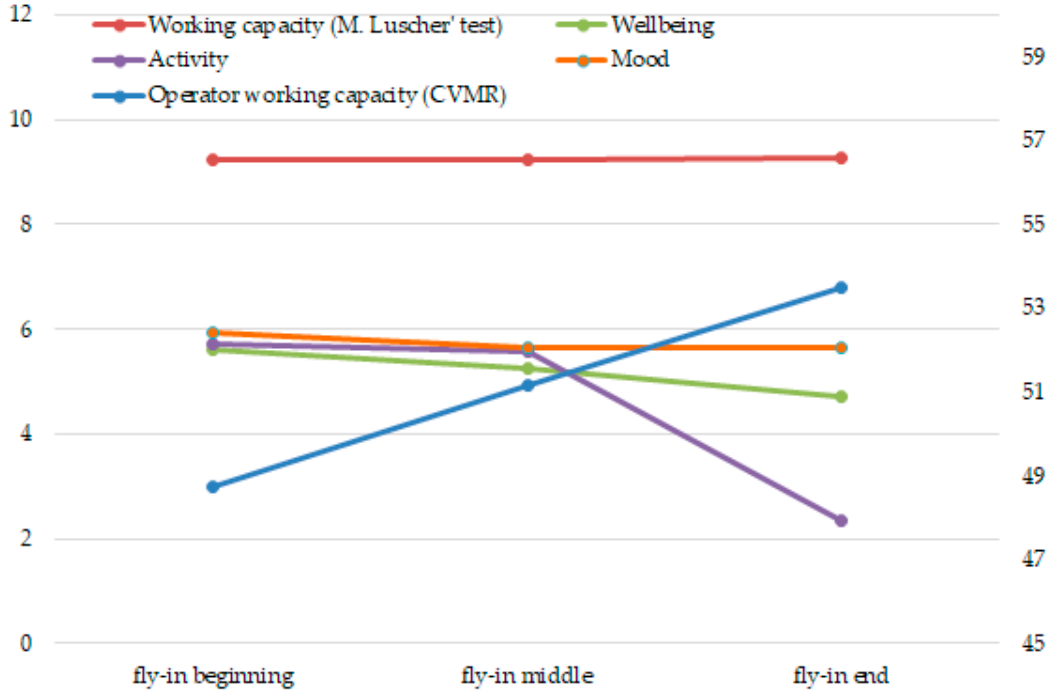
Figure 2. The working capacity dynamics among oil and gas employees during the fly-in period.